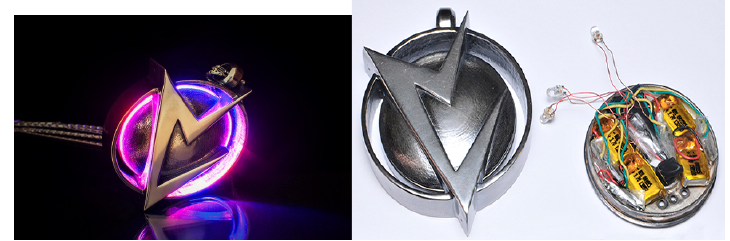
Fig. 1. Prototype of a digital effect jewel for the movie Iron Sky: The Coming